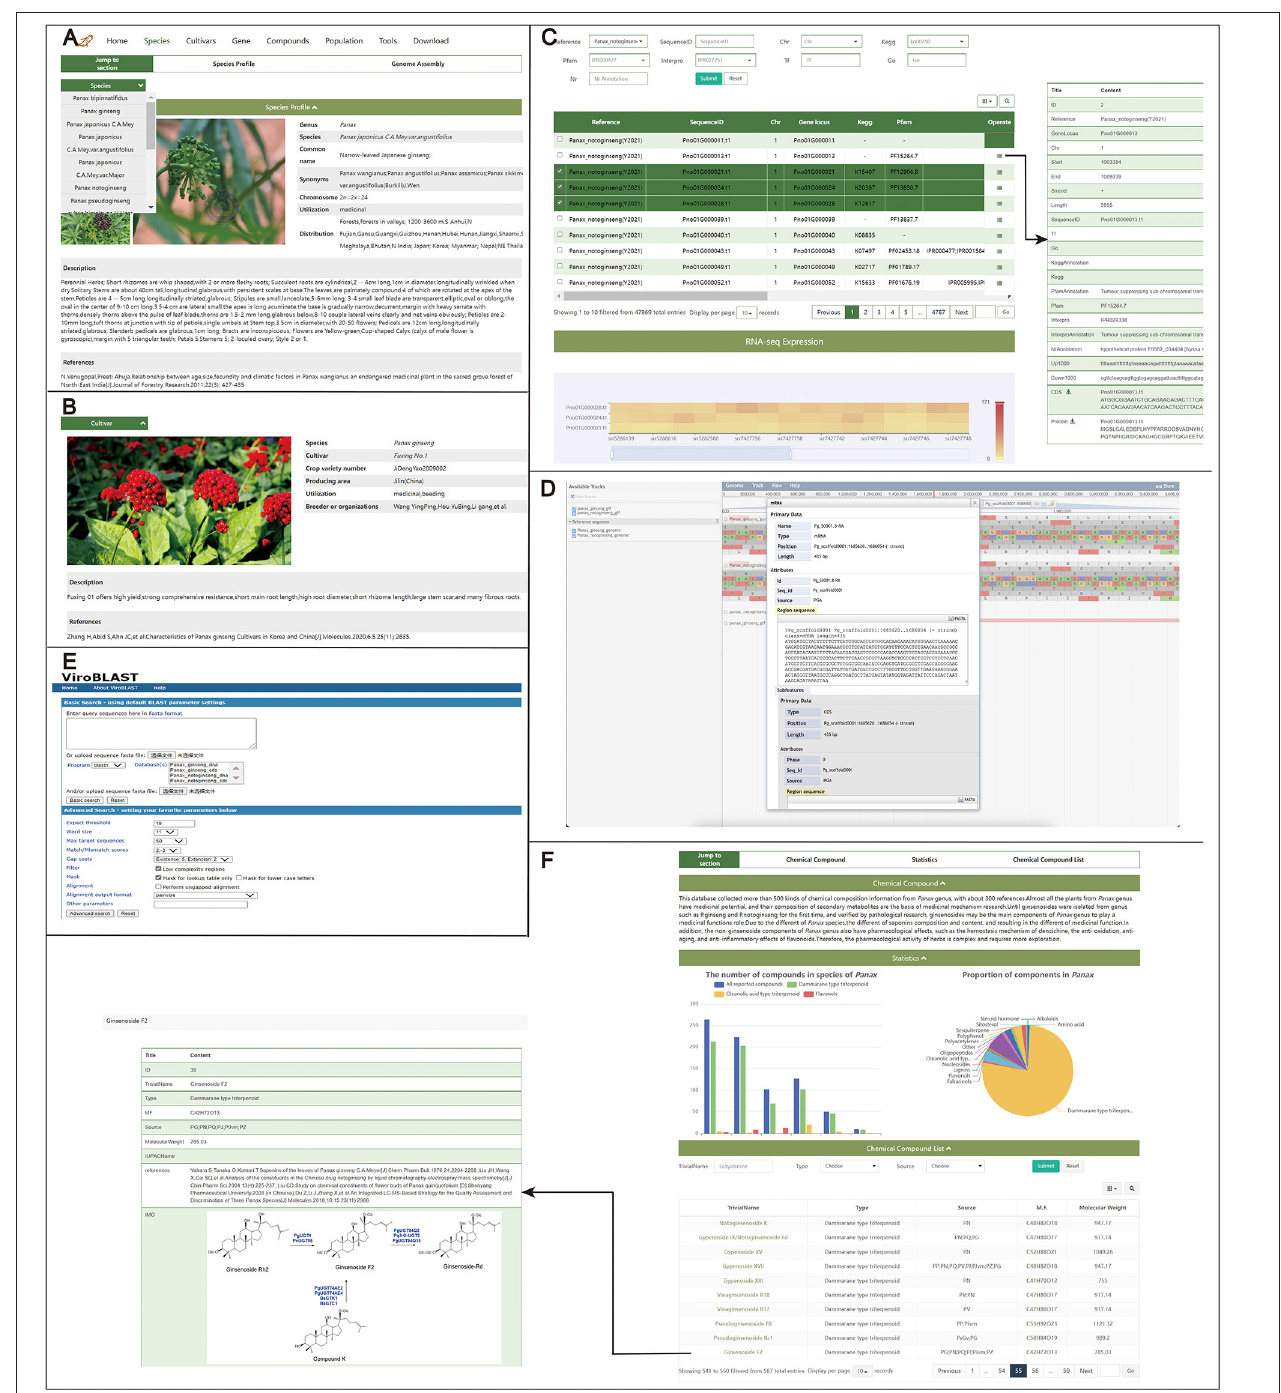
FIGURE 2 | Query interface to retrieve information on germplasm, genomic application, and compounds. (A) Species page.16 species information on this page. (B) Cultivars page.62 cultivars information on this page. (C) Gene page. Search for genetic information including functional annotation, CDS, and protein sequence, etc. JBrowse (D) based on JavaScript for visual analysis of the genome annotation. Blast server (E) to perform homology searches with different data sets. (F) Compounds page. Search for the distribution, known metabolic pathways, or other characteristics of a particular